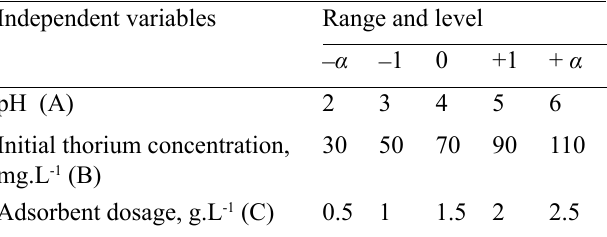
Table 2. Experimental ranges and levels of the independent variables.